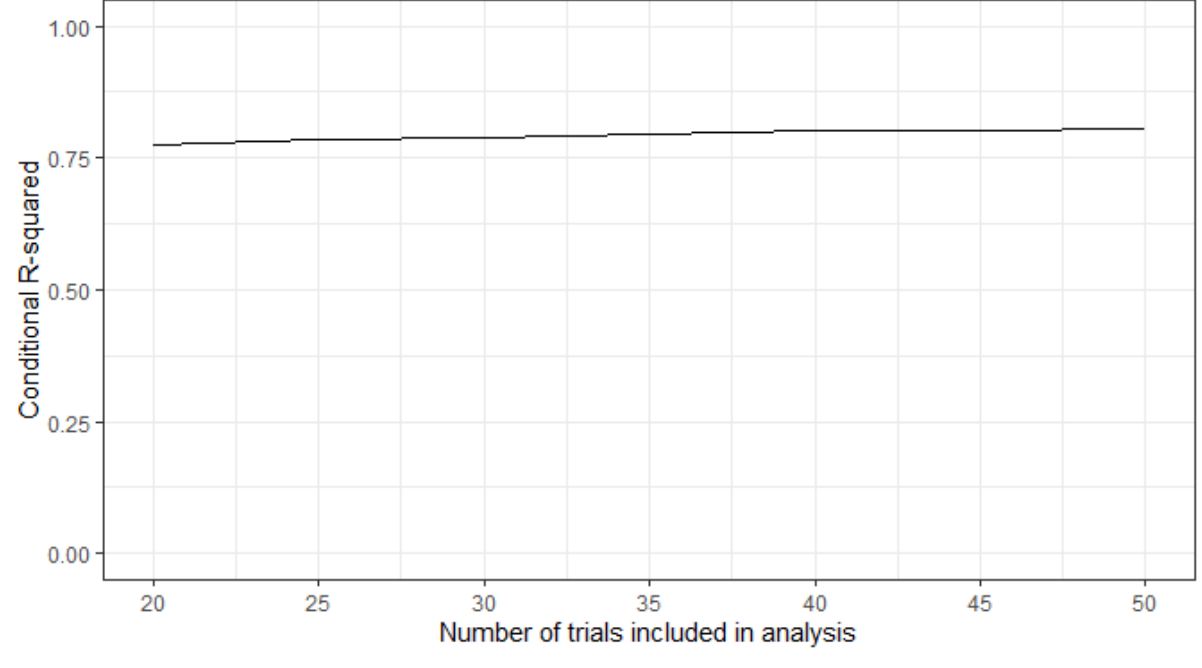
Figure 3. The proportion of variance explained by the model (conditional R 2 ) across all participants based on the number of trials that were included in the analysis.